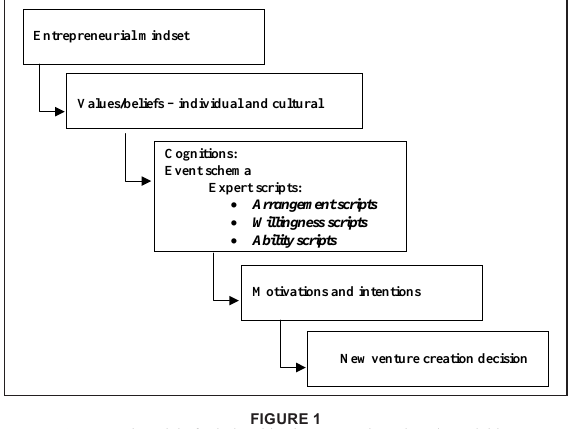
figure 1 Conceptual model of relationships between selected study